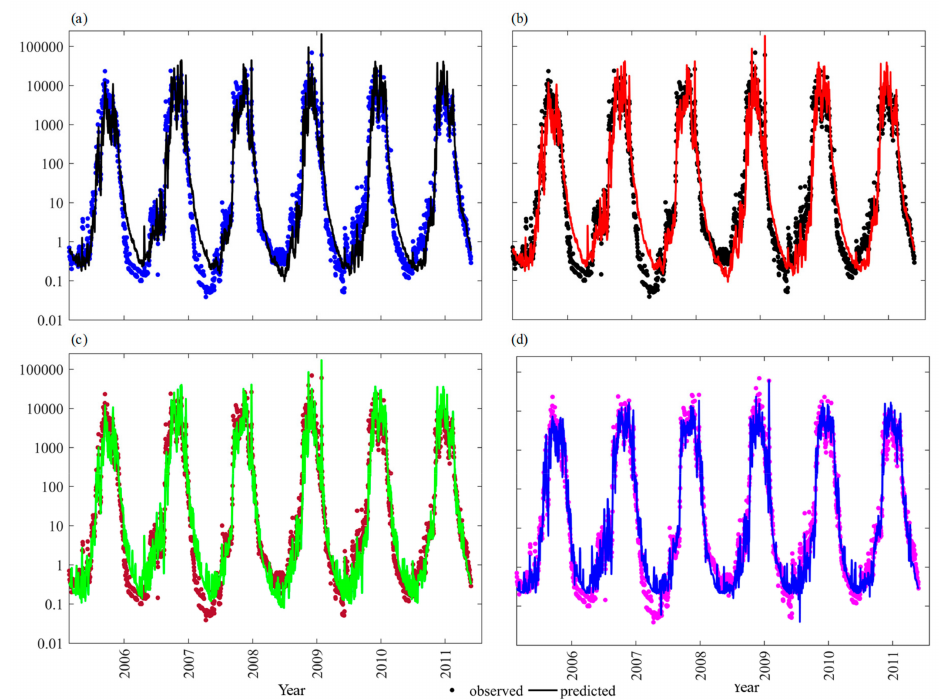
Figure 12. Observed and predicted sediment ( a ) SRC (Q w and Q s ) model, ( b ) power model (Q w ), ( c ) log transform linear model (Q w and R t ), and ( d ) ANN model.